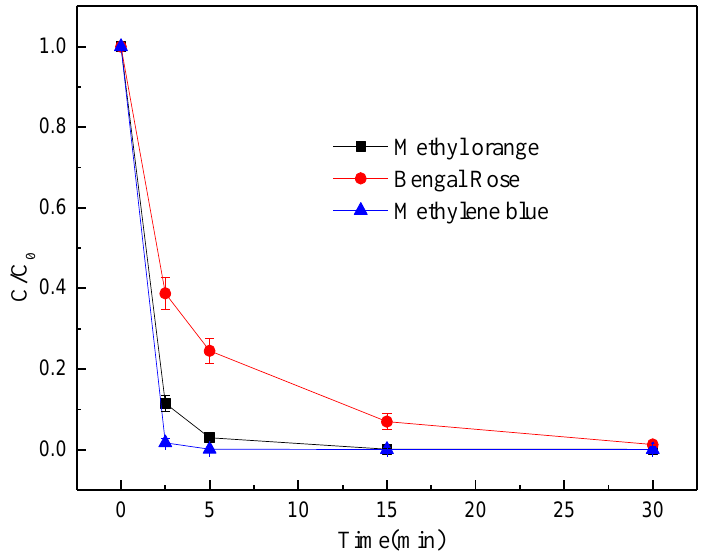
Figure 6. Decolorization efficiency of MEM organic pollutants.